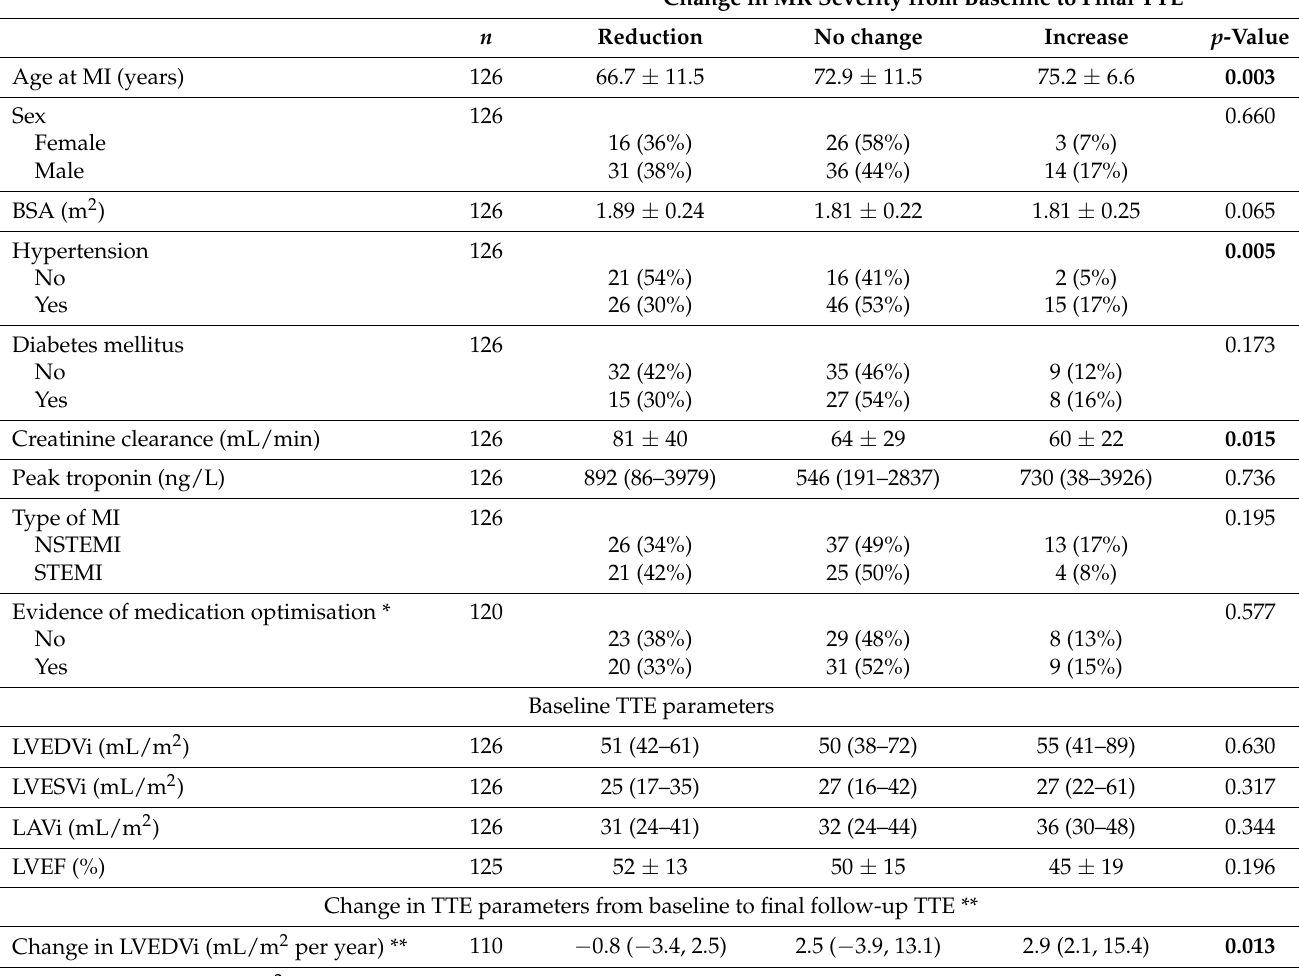
Table 4. Associations between baseline factors and the change in MR severity between baseline and the final